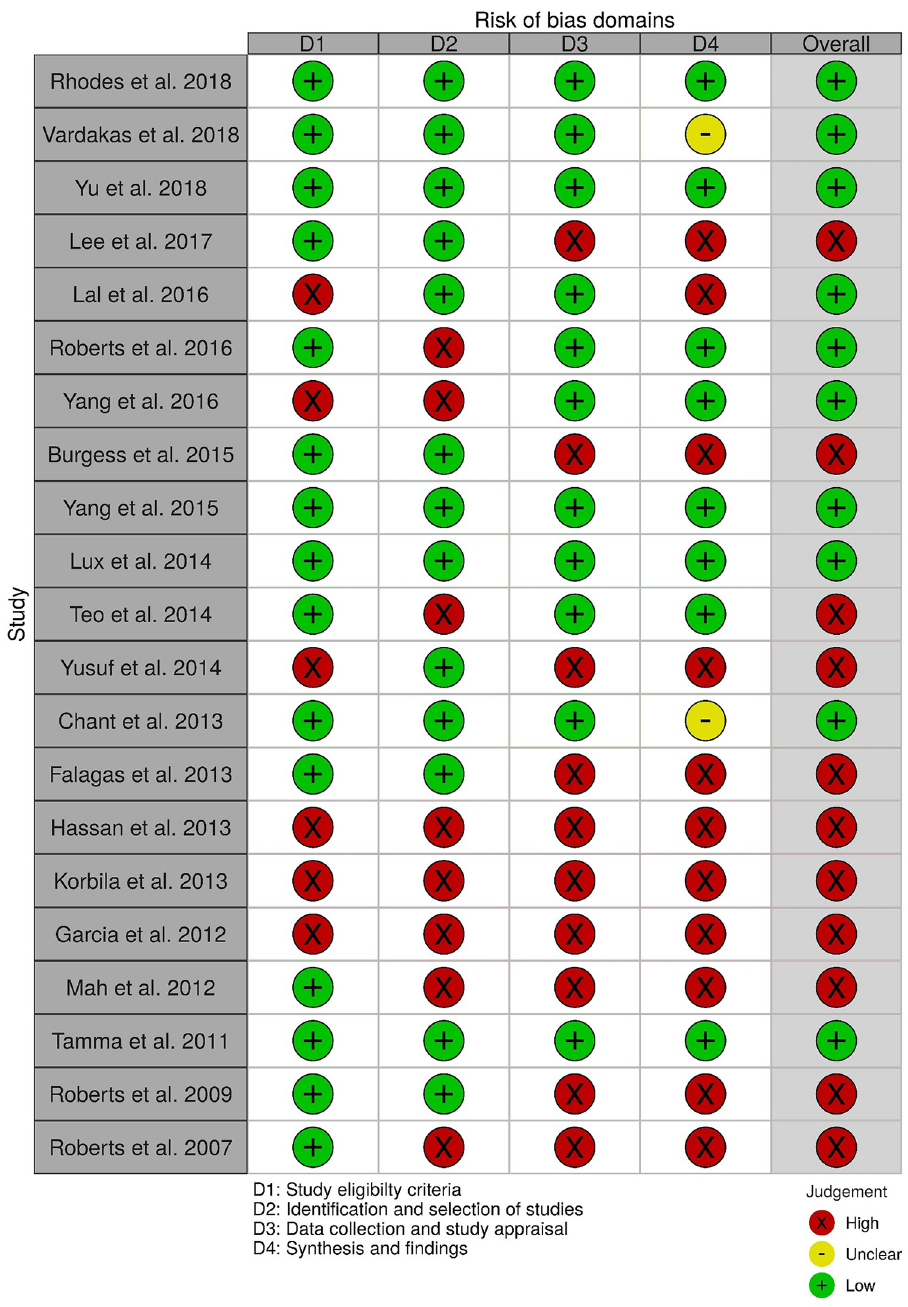
Fig 2. ROBIS. Results of the risk of bias evaluation of included systematic reviews using the ROBIS tool (Risk of Bias in Systematic Reviews), categorized per its four domains; D1 -study eligibility criteria, D2 –identification and selection of studies, D3 –data collection and study appraisal, D4 –Synthesis and